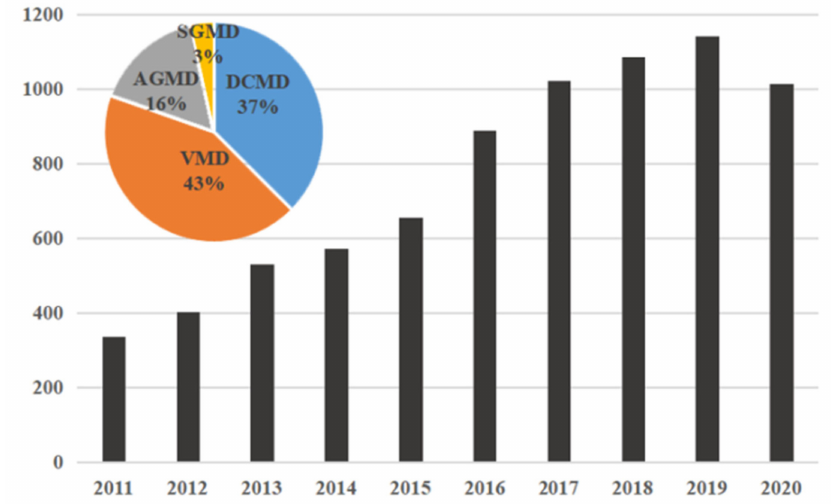
Figure 2. Growth in the number of refereed papers on membrane distillation from 2011 to